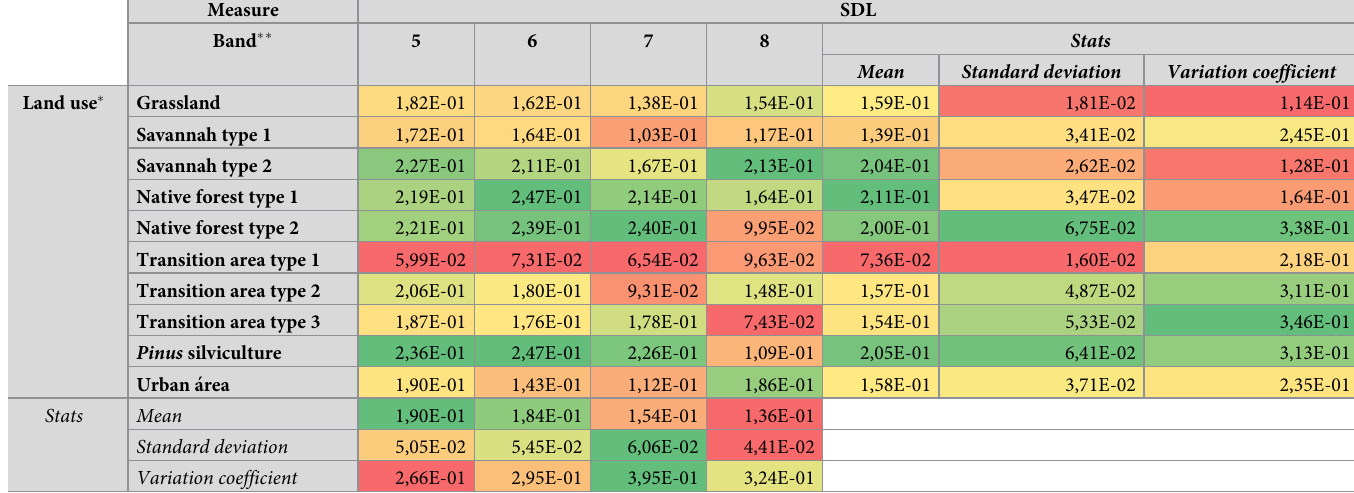
Standard deviation Variation coefficient